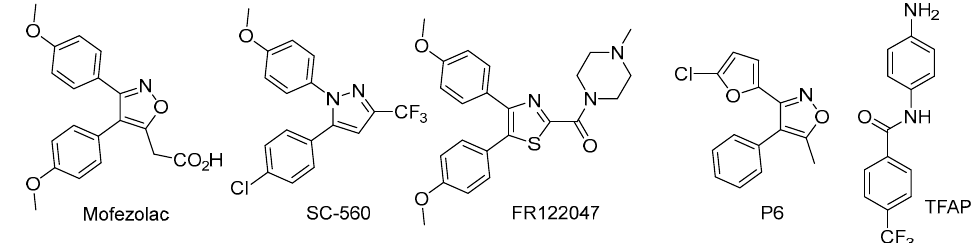
Figure 1. Representative COX-1 selective inhibitors.